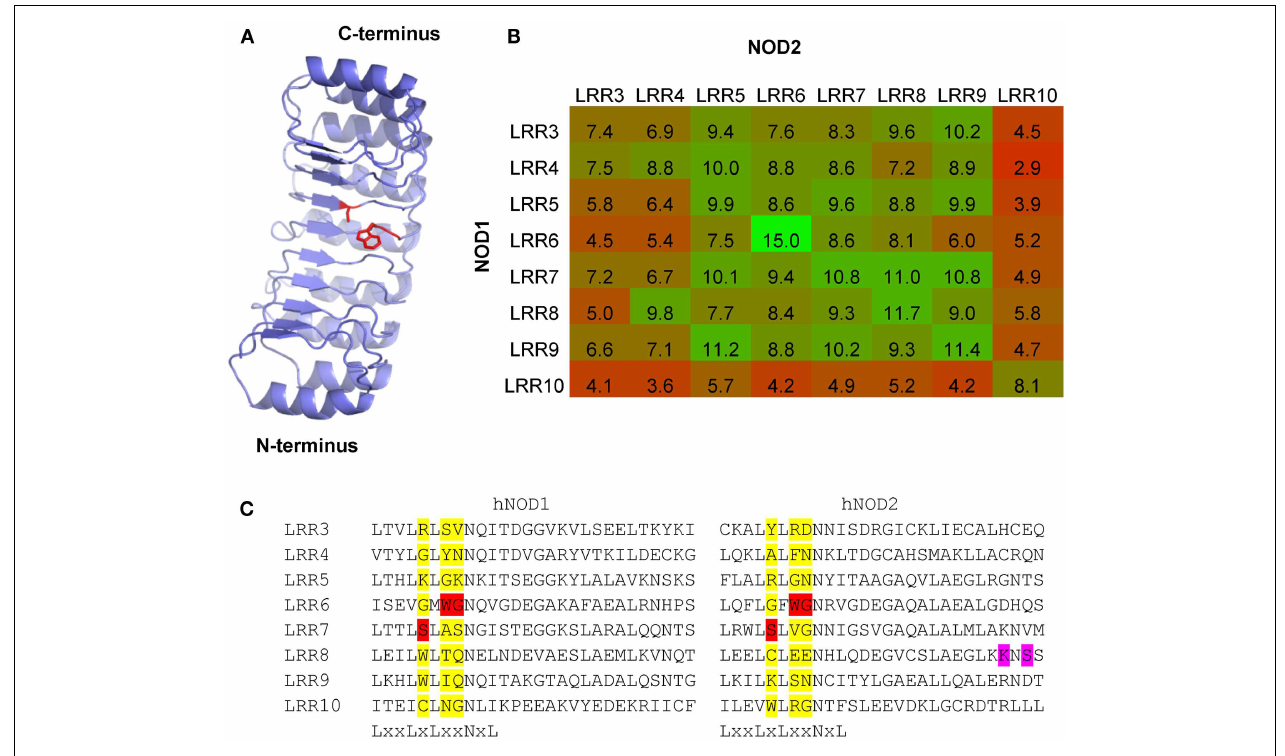
and coelacanth.The number in each box represents the average number of identical residues in a cross-species pairwise comparison between the relevant LRR motifs. Boxes are colored on a graded scale from green (most similar) down to red (least similar). (C) The three residues (highlighted red) are found in the X3, X4, and X5 position of the LRR consensus motif.These positions are populated by a wide range of different amino acids (highlighted yellow). K989 and S991 (highlighted in purple), two residues in human NOD2 implicated in ligand recognition and receptor activation, are located in a region of the protein missing in the Actinopterygii due to an exon